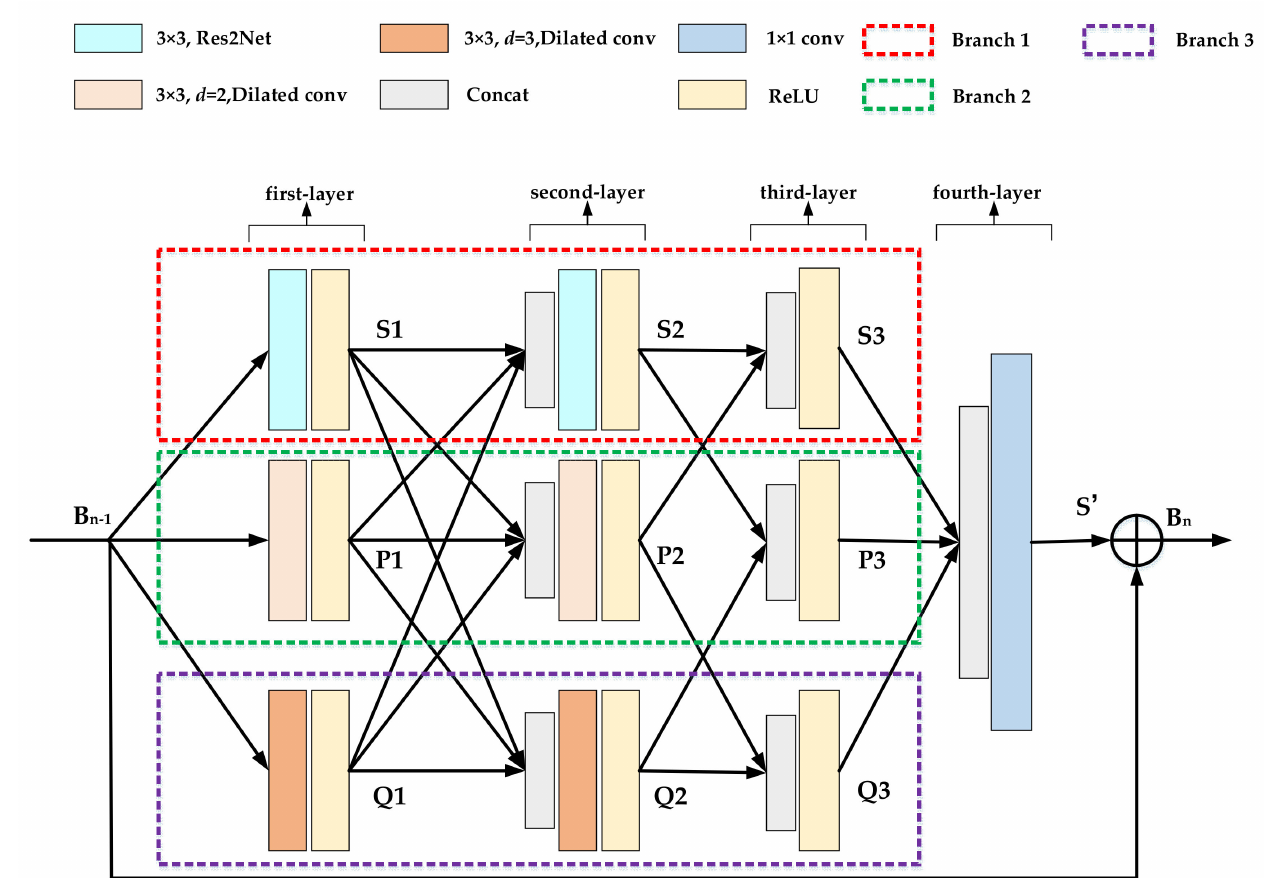
Figure 2. MSDRB structure, with four layers divided into three branches. Branch 1 contains the hierarchical residual-like connections (namely, Res2Net) residual block, activation function (i.e., rectified linear unit, ReLU), and concatenation operation. Branches 2 and 3 contain the dilation convolution with dilation rates d of 2 and 3, respectively; ReLU; and concatenation operation. The outputs of branches S 3 , P 3 , and Q 3 are output as S (cid:48) after concatenation and 1 × 1 convolution. Finally, S (cid:48) is feature-added with B n − 1